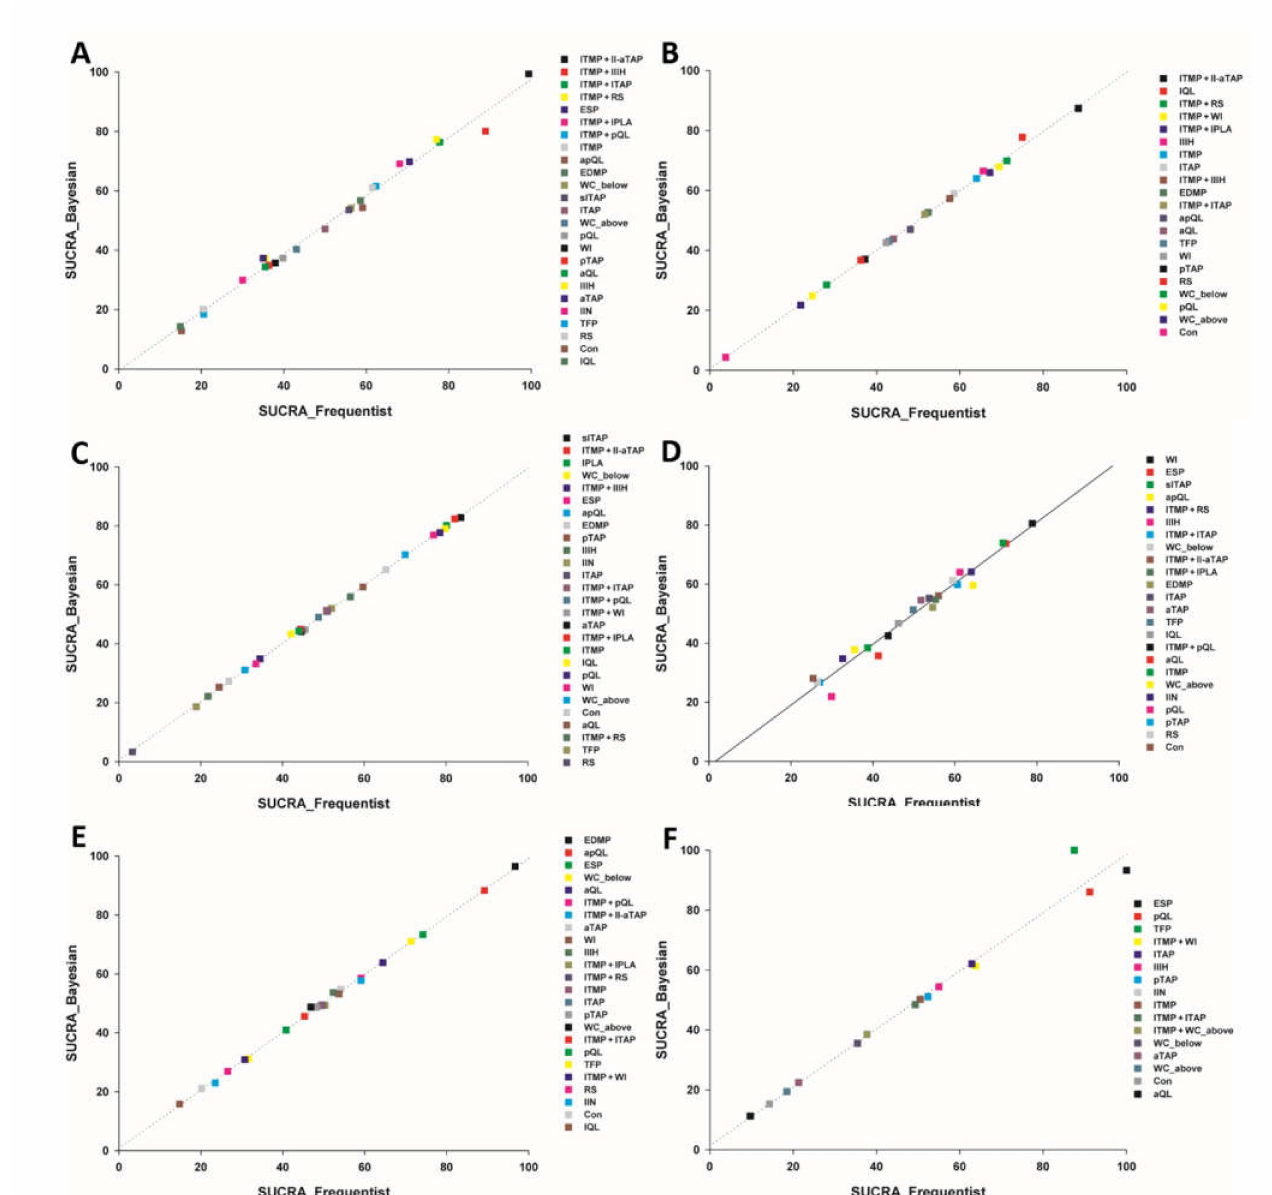
Figure 4. The expected mean ranking and surface under the cumulative ranking curve (SUCRA) values from a frequentist and Bayesian model of all outcomes. SUCRA is a numeric presentation of the overall ranking. The higher the SUCRA value and the closer to 100%, the better the rank of the intervention. ( A ) Pain at rest 6 h after surgery; ( B ) Postoperative cumulative 24 h morphine equivalent consumption; ( C ) Pain at rest 24 h after surgery; ( D ) Dynamic pain at 6 h after surgery; ( E ) Dynamic pain at 24 h after surgery; ( F ) The time to first analgesic